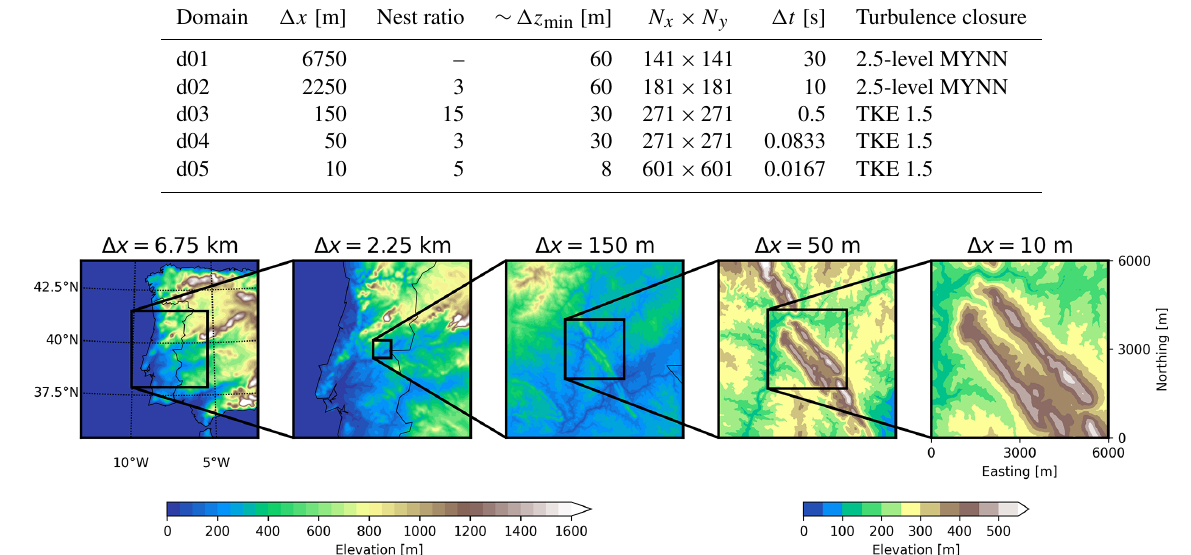
Table 1. Parameters used for the nested multi-scale WRF–LES–GAD setup. For the vertical resolution, (cid:49)z min is for the first grid point above the surface and is approximate due to the nature of the terrain-following coordinate system in WRF.